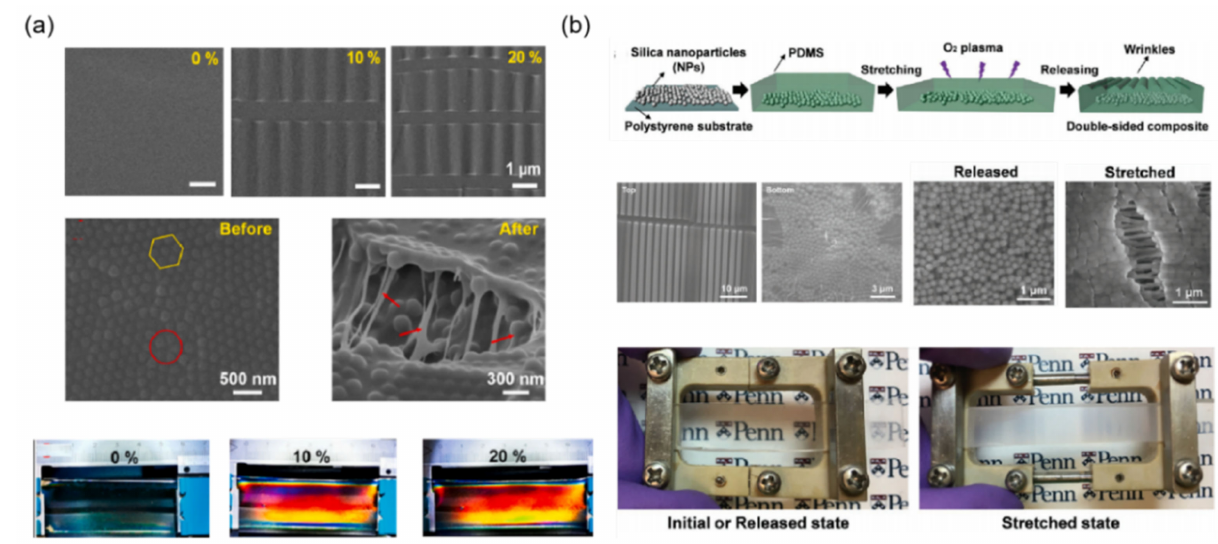
Figure 6. Two strategies of mechanoresponsive smart windows based on surface and interface modulation synergistically: ( a ) surface wrinkle, novel interface dynamic formation dynamic control of interface parameters [43] Copyright 2021, Elsevier, ( b ) surface wrinkle and novel interface dynamic generation [44] Copyright 2018, John Wiley and